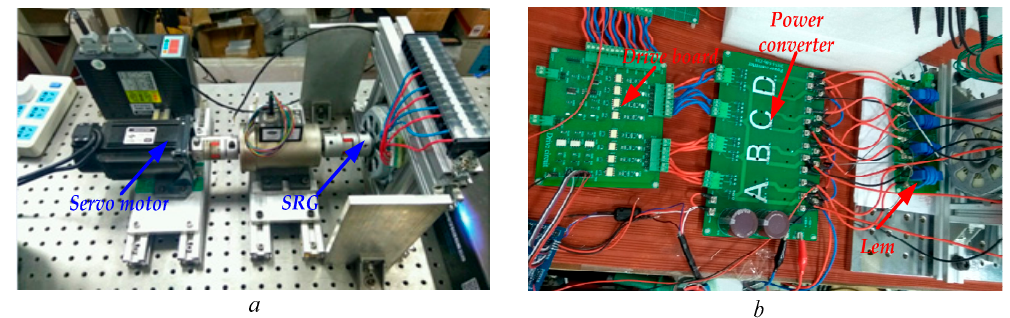
Figure 8. The photograph of the experimental platform of SRG power generation. ( a ) Experiment platform of SRG; ( b ) control circuits and the power converter.